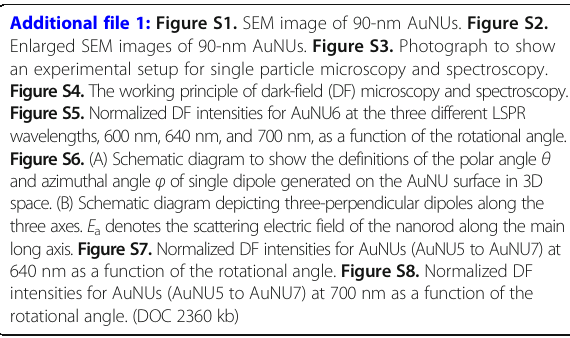
an experimental setup for single particle microscopy and spectroscopy. Figure S4. The working principle of dark-field (DF) microscopy and spectroscopy. Figure S5. Normalized DF intensities for AuNU6 at the three different LSPR wavelengths, 600 nm, 640 nm, and 700 nm, as a function of the rotational angle. Figure S6. (A) Schematic diagram to show the definitions of the polar angle θ and azimuthal angle φ of single dipole generated on the AuNU surface in 3D space. (B) Schematic diagram depicting three-perpendicular dipoles along the three axes. E a denotes the scattering electric field of the nanorod along the main long axis. Figure S7. Normalized DF intensities for AuNUs (AuNU5 to AuNU7) at 640 nm as a function of the rotational angle. Figure S8. Normalized DF intensities for AuNUs (AuNU5 to AuNU7) at 700 nm as a function of the rotational angle. (DOC 2360